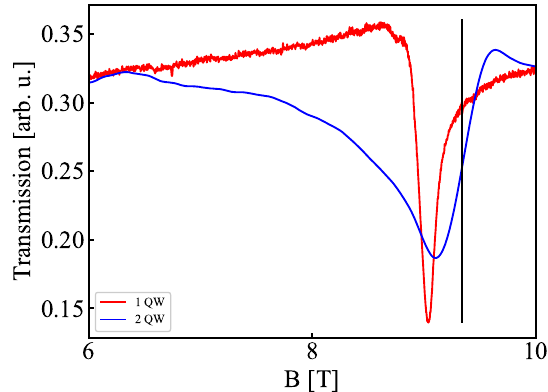
Figure 8. Transmission spectra of samples with etched grating of the period equal to 8 µ m: single and two quantum wells. The wavelenght of radiation was 118.8 µ m. The vertical bar indicated position of the CR in unprocessed